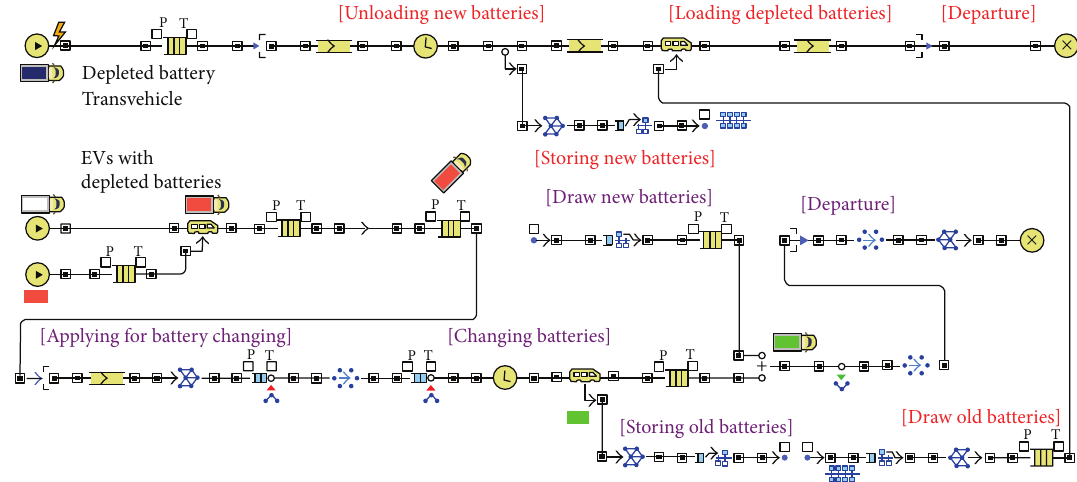
Figure 9: Main process of the battery-changing